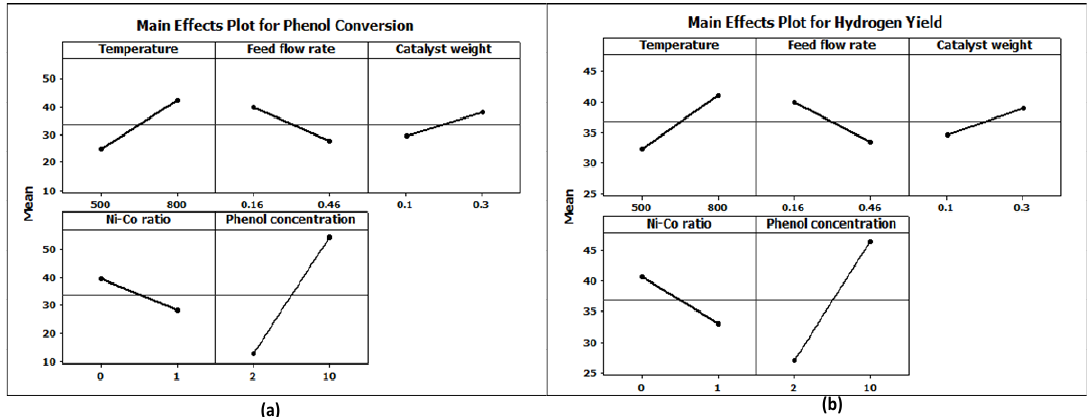
Figure 9. Main effect plot for ( a ) Y 1 and ( b ) Y 2 .